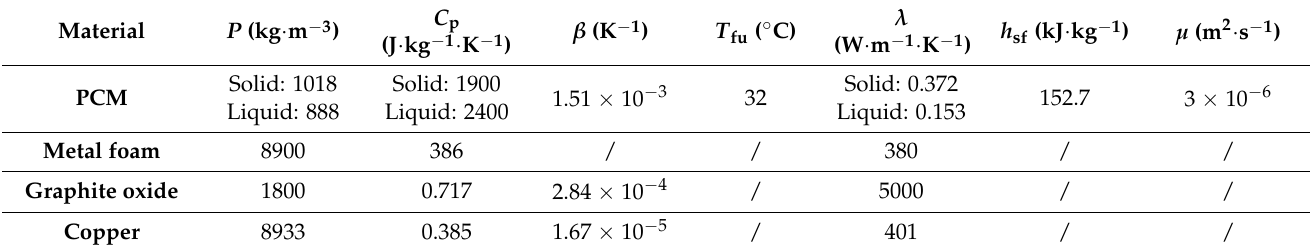
Table 1. Thermophysical characteristics of the materials used in this study [37,38].